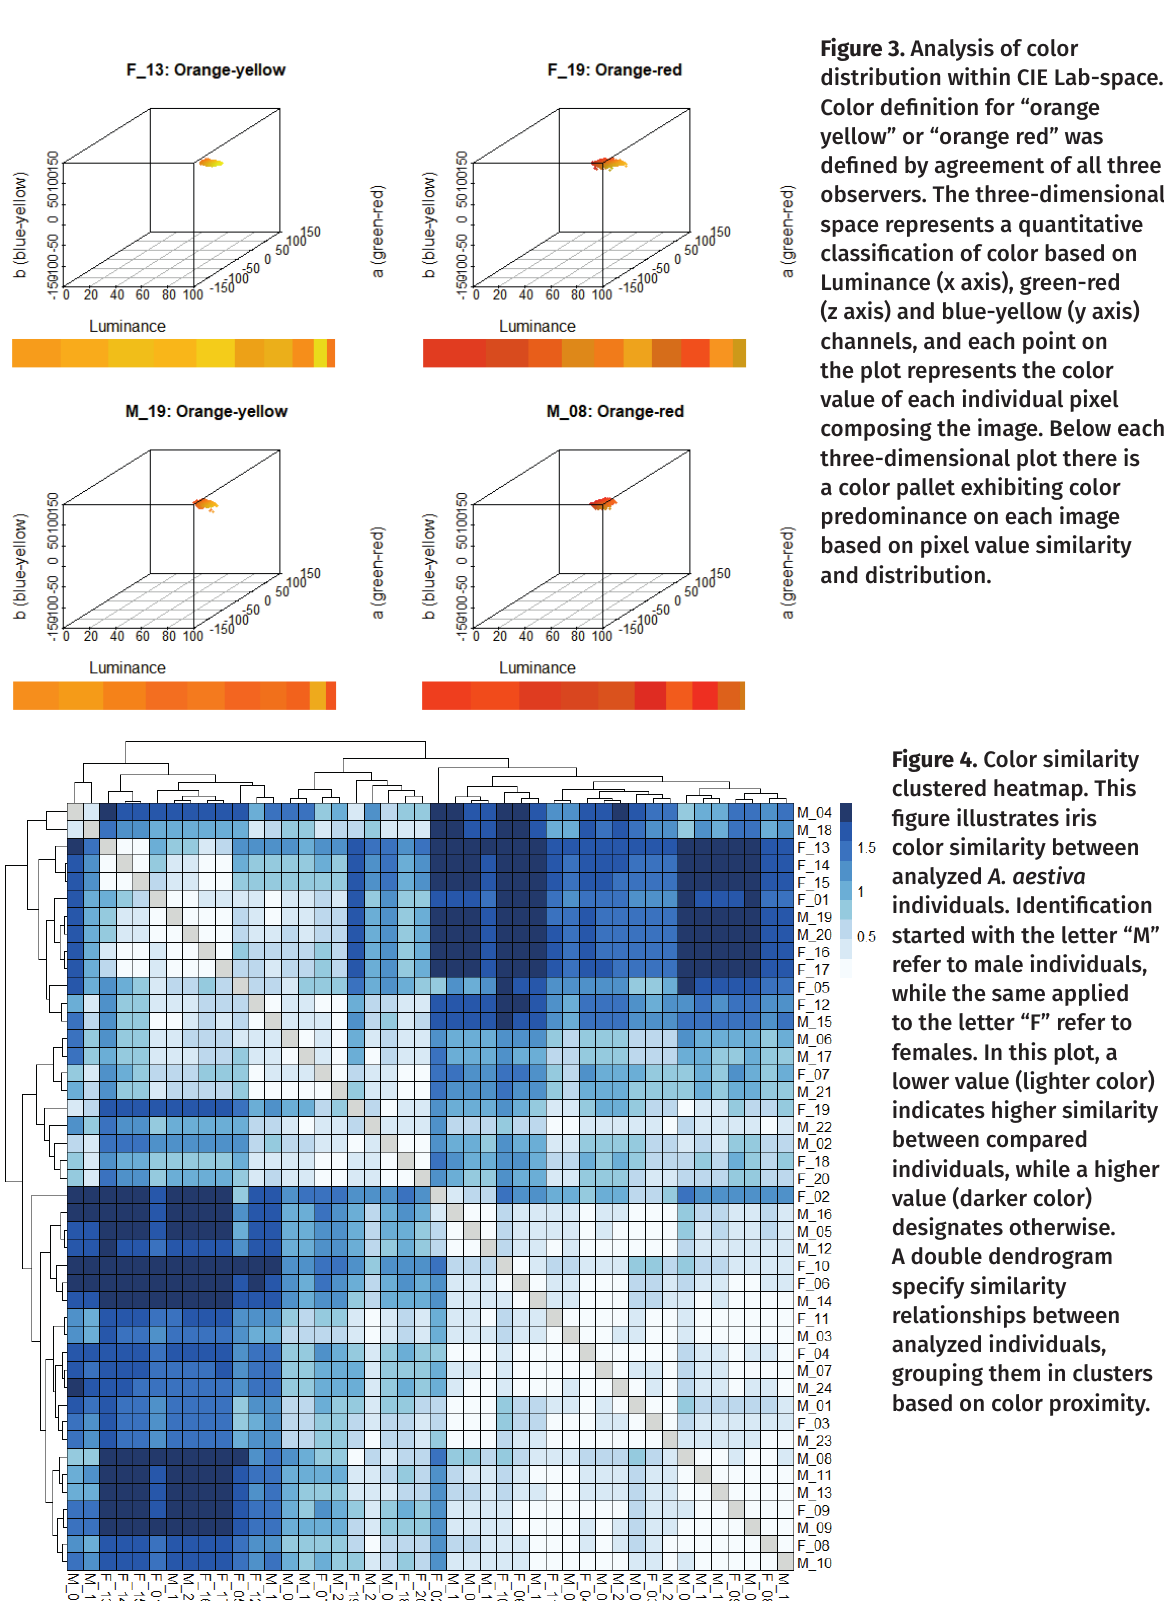
Figure 4. Color similarity clustered heatmap. This fi gure illustrates iris color similarity between analyzed A. aestiva individuals. Identifi cation started with the letter “M” refer to male individuals, while the same applied to the letter “F” refer to females. In this plot, a lower value (lighter color) indicates higher similarity between compared individuals, while a higher value (darker color) designates otherwise. A double dendrogram specify similarity relationships between analyzed individuals, grouping them in clusters based on color